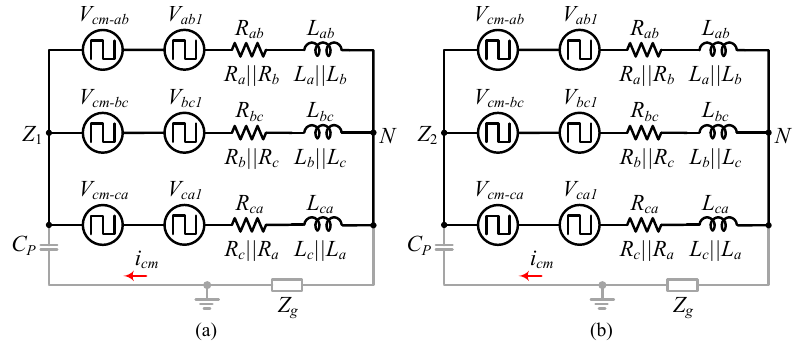
Figure 2. DCM-232 common mode model: ( a ) V DC 1 and ( b ) V DC 2 . Table 1. Switching configurations of the three-phase DCM-232 transformerless inverter.